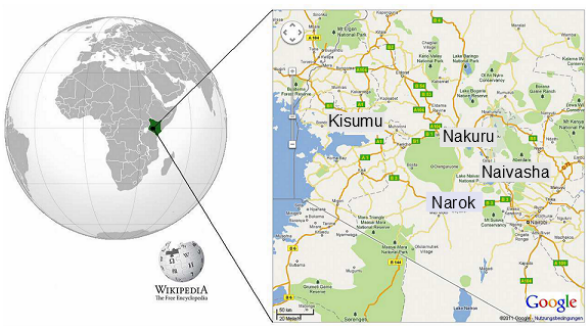
Fig. 3. Location of the used weather stations in Kenya. Nakuru Fig. 2. Schematic of (a) positive IOD mode, (b) negative IOD mode (from Japan Agency for Marine Earth Science and Technology, Fig. 2. Schematic of (a) positive IOD mode, (b) negative IOD http://www.jamstec.go.jp). N. Itoh and N. Marwan: An Extended SST for the Investigation of Kenyan Precipitation Data mode (from Japan Agency for Marine Earth Science and Technol- ogy ( http://www.jamstec.go.jp )).